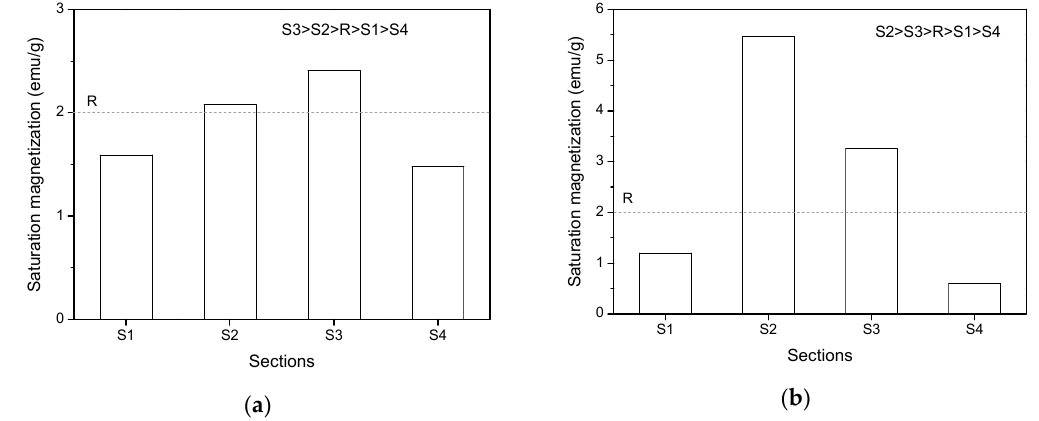
Figure 15. Saturation magnetization of cementitious powders in parallel plate after constant shearing at ( a ) 40 s − 1 and ( b ) 240 s − 1 .